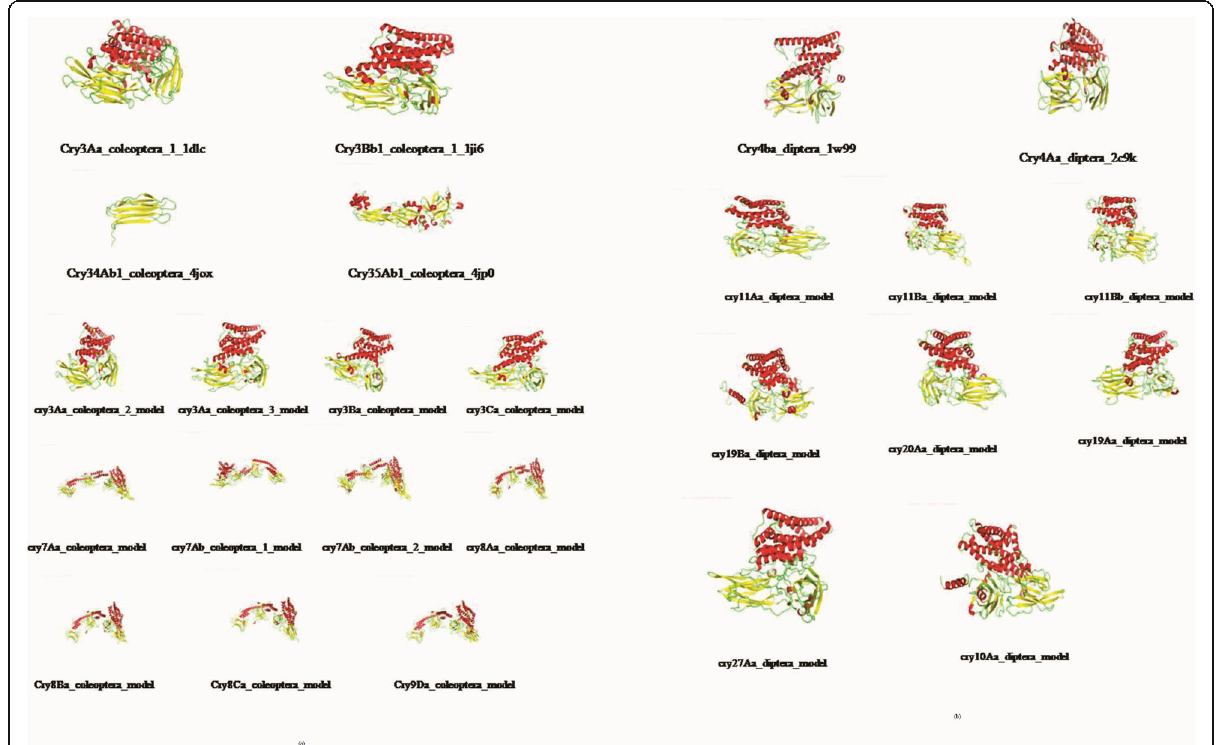
Fig. 5 a Experimental and predicted 3D structures (model) of Cry proteins having toxicity for Coleoptera insects. b Experimental and predicted 3D structures (model) of Cry proteins having toxicity for Diptera insects